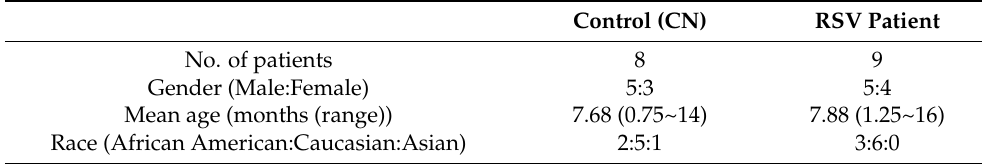
Table 1. Patient gender, age, and race information.